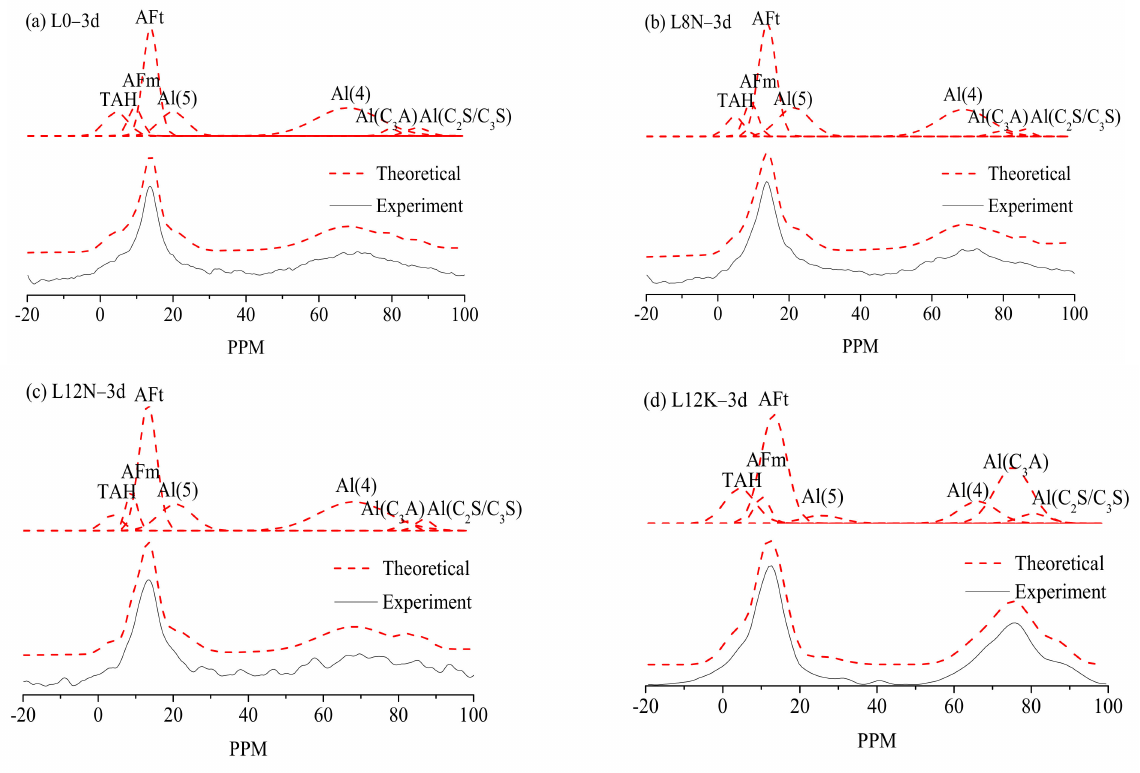
Figure 15. 27 Al MAS NMR spectra of LHPC pastes with different alkali sulfates contents at 3 d. ( a ) LHPC pastes with alkali content of 0.4% at 3d; ( b ) LHPC pastes with alkali content of 0.8% (added with Na 2 SO 4 ) at 3d; ( c ) LHPC pastes with alkali content of 1.2% (added with Na 2 SO 4 ) at 3d; ( d ) LHPC pastes with alkali content of 1.2% (added with K 2 SO 4 ) at